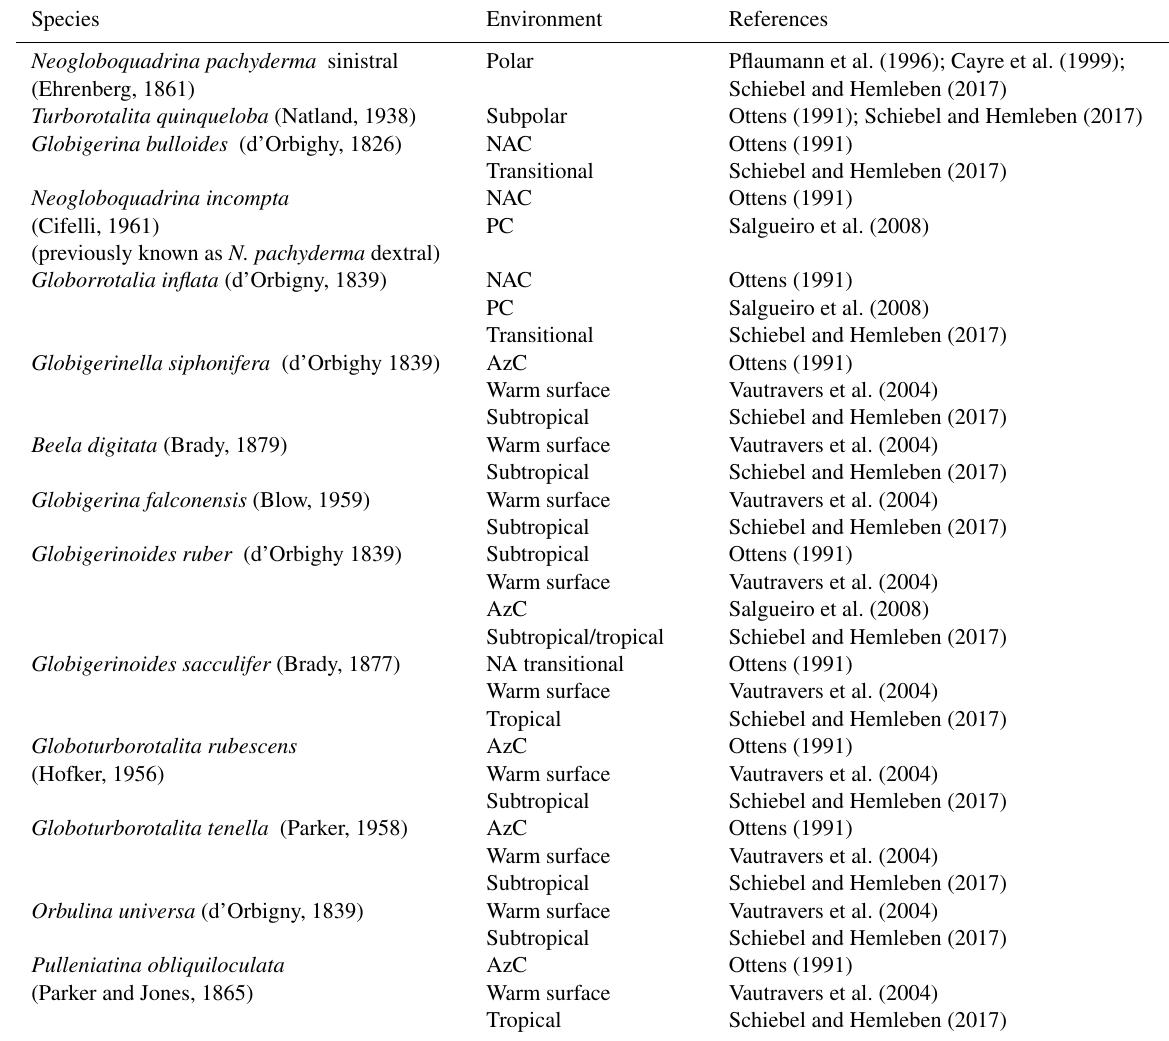
Table A1. Planktonic foraminifer species used in this